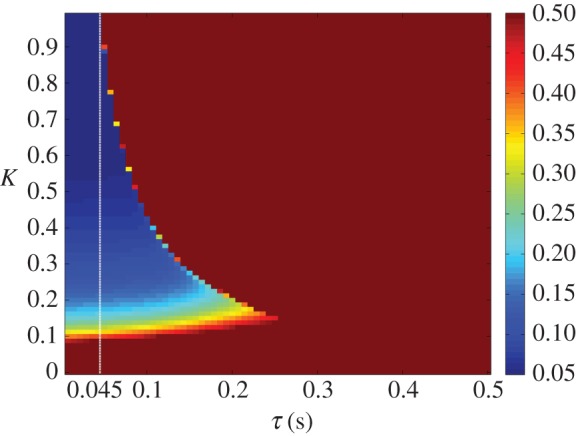
RMSE in the 100 s after an impulse torque disturbance of magnitude 700 is applied at both joints, plotted as a function of K and τ on a heat map. The heat map is saturated above an error of 0.5, representing a failure to track the target. Higher values of K reduce the effect of the disturbance, meaning that the stable region is bounded by the approximate Kτ=0.14 stability boundary, as well as a lower limit in K of approximately 0.1. A white dotted line indicates the highest delay value (0.045 s) at which the original control loop is stable (subject to the same conditions).